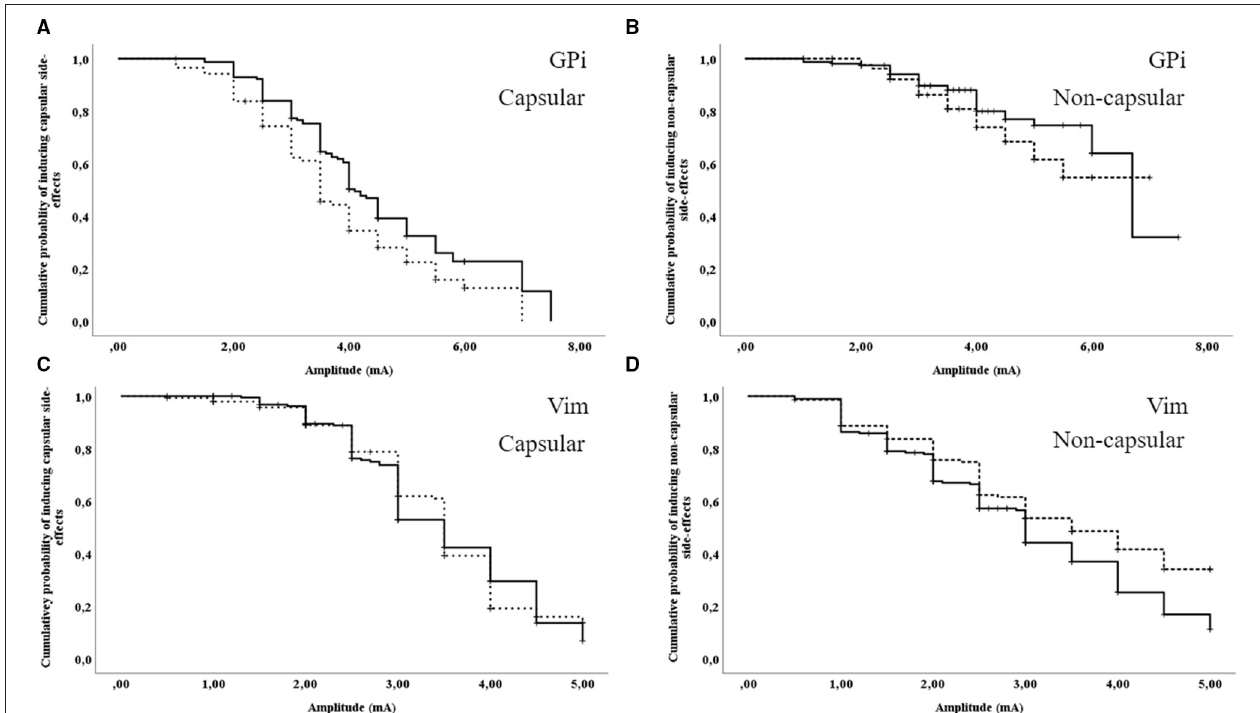
FIGURE 2 | Unpaired survival analyses for the induction of capsular and non-capsular side-effects. (A) GPi DBS: induction of capsular side-effects; (B) GPi DBS: induction of non-capsular side-effects; (C) Vim DBS: induction of capsular side-effects; (D) Vim DBS: induction of non-capsular side-effects. Dashed line: intraoperative assessment; continuous line: postoperative assessment. Vertical ticks indicate